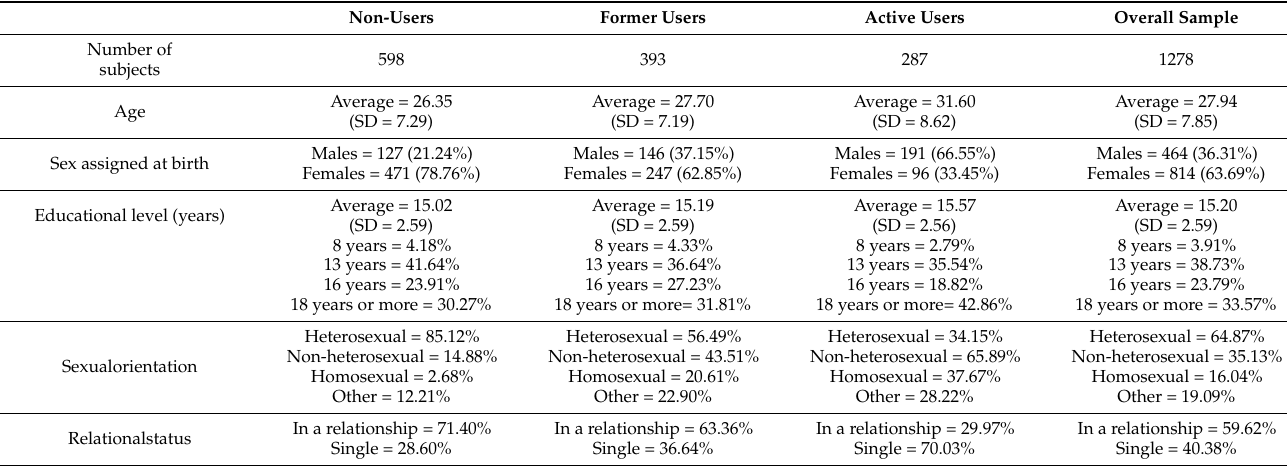
Table 1. Demographic features of the total sample and the three split samples: non-users, former users, active users. (Percentages were rounded by excess from 0.05 up and by defect from 0.05 excluded